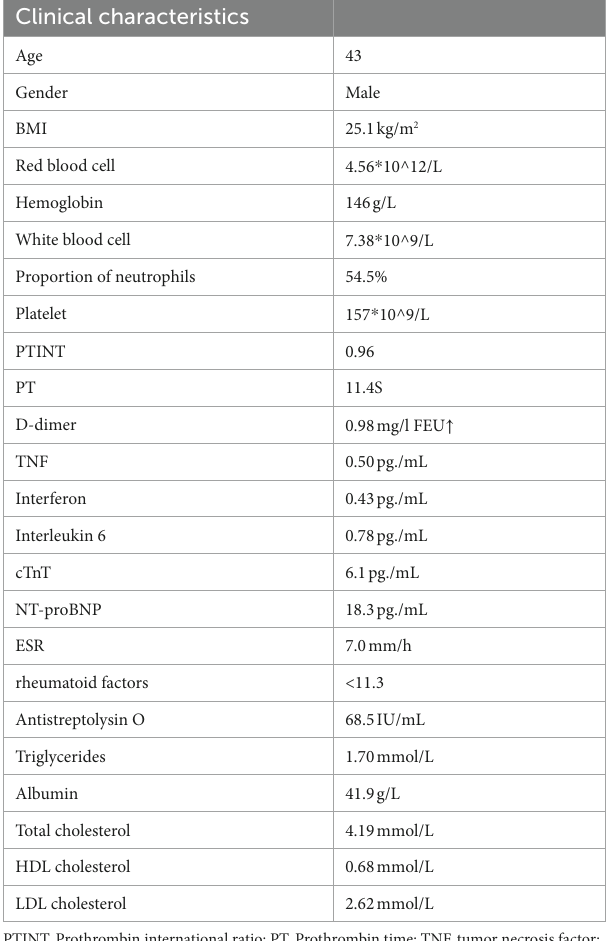
TABLE 1 Clinical characteristics of the patient on admission. Clinical